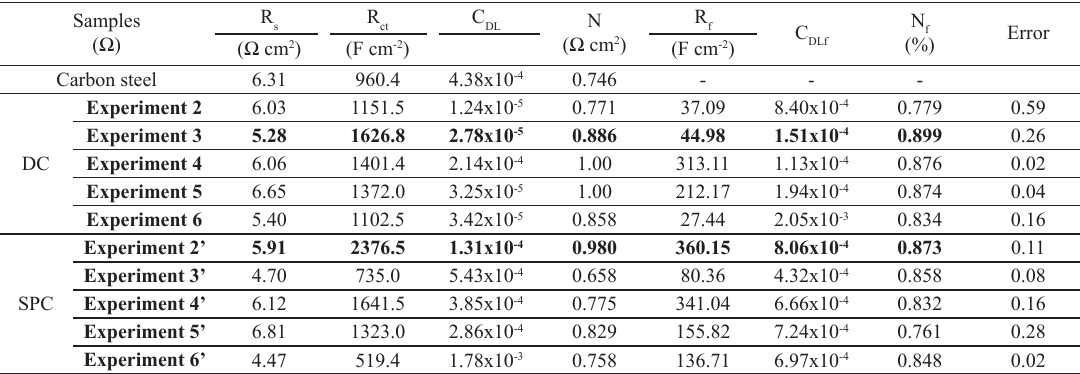
Table 6 – Simulated results obtained from the EIS data for the DC and PC produced coating/substrate systems in NaCl 0.5 mol L -1 (Figure 6), using the equivalent circuits presented in Figure